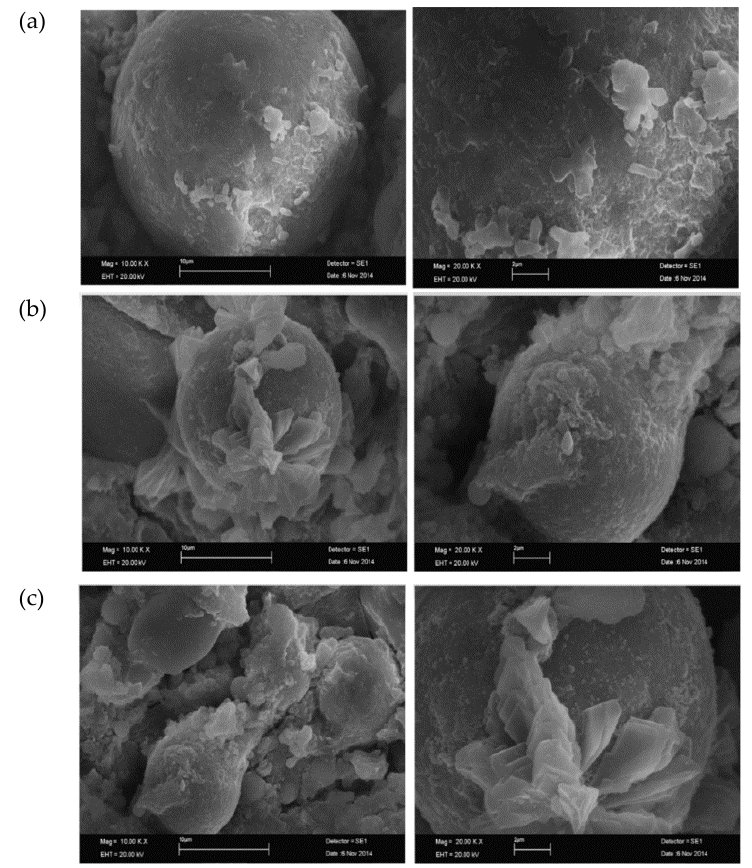
Figure 18. SEM images of 10% slag replacement of geopolymer mortar: ( a ) control sample; ( b ) 10% DSF; ( c ) 10% USF [106]. (Reprinted with permission from the publisher, Elsevier; License No. 5471711440902).